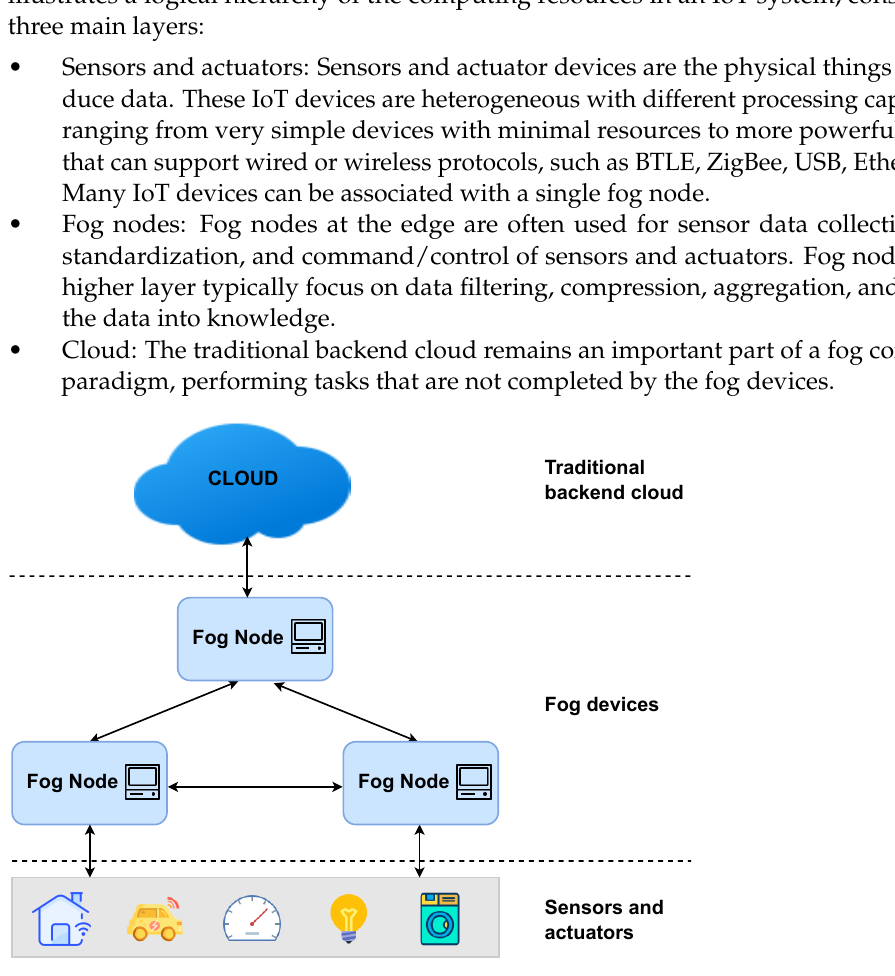
Figure 3. Fog Computing